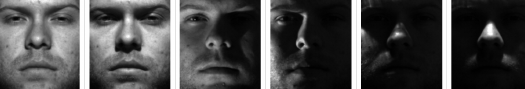
Figure 5. Yale B Dataset.